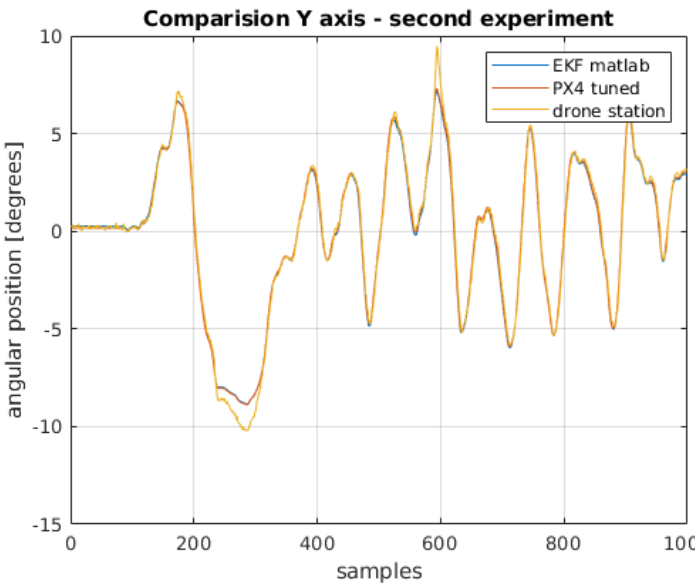
Figure 16. Comparison of angular position for Y-axis.